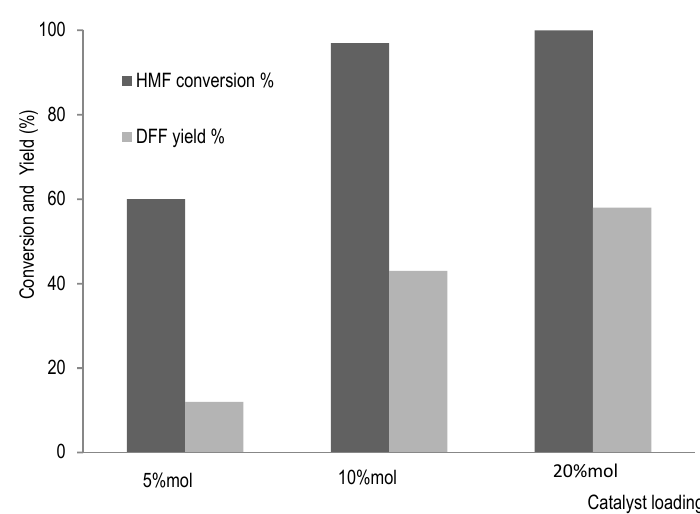
Figure 5. HMF oxidation to 2,5-Diformylfuran (DFF) catalysed by NaBr/POM/H 2 O 2 .